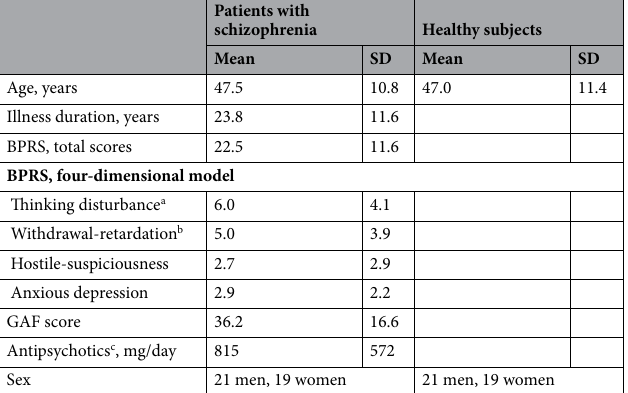
Table 1. Clinical variables in patients with schizophrenia and case-matched healthy subjects. a Corresponding to positive symptoms. b Corresponding to negative symptoms. c Chlorpromazine equivalent dose.